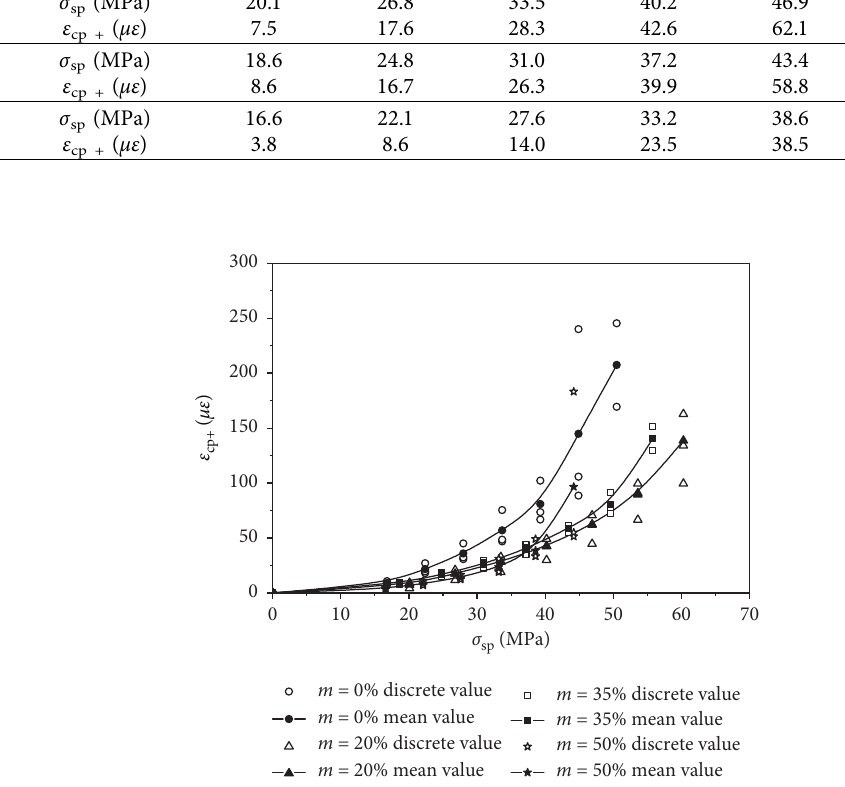
Figure 10: Accumulated creep-stress ( ε cp+ - σ sp ) curves of concrete with various fly ash replacement ratios ( m